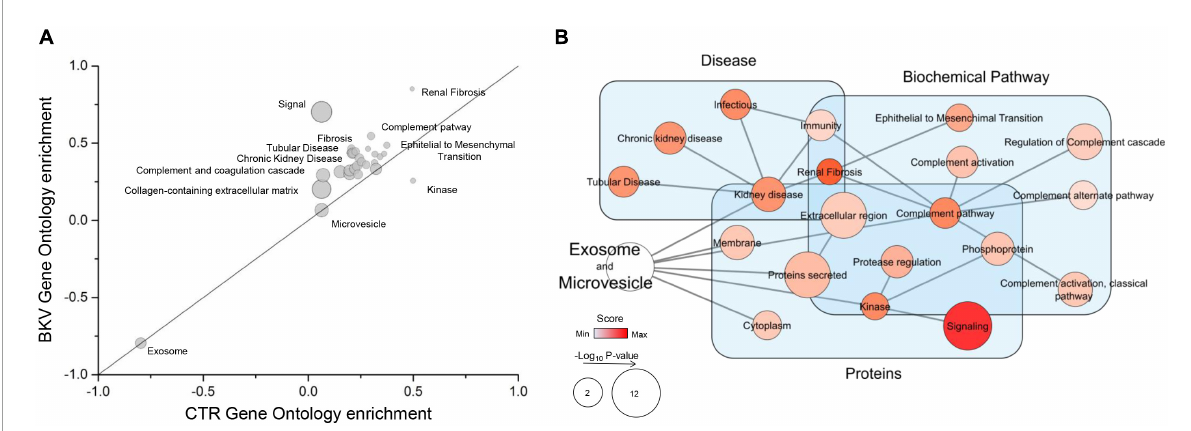
FIGURE2 Gene Ontology (GO) enrichment analysis and Gene Set Enrichment Analysis (GSEA) of the total proteins identified. (A) Plot shows the GO enrichment of total proteins in exosomes and microvesicles isolated from urine of patients with BKV infection and CTR. In the graph, the points located on the straight line passing through the coordinates (1x, 1y) and (-1x, -1y) are the equally enriched signatures, while those above or under this line are positively enriched in BKV or CTR, respectively, (see detail in Supplementary Table 2 ). The distance from this line is proportional to the enrichment score in one of the two groups. The size of circles is proportional to the probability after correction for multiple comparison. (B) Network of GSEA results. GSEA is a computational method that determines whether an a priori defined set of proteins shows statistically significant differences between two phenotypes. In particular, the diagram summarizes the GSEA results mapped as a network. Nodes and edges represent, respectively, the GO annotation terms and their interaction. The color intensity of each node indicates the level of enrichment in BKV samples and size is proportional to its p -value. “Signal” is the annotation term with the highest enrichment score. In addition, the different GO terms were clustered in the function of their GO annotation (light blue rectangles).